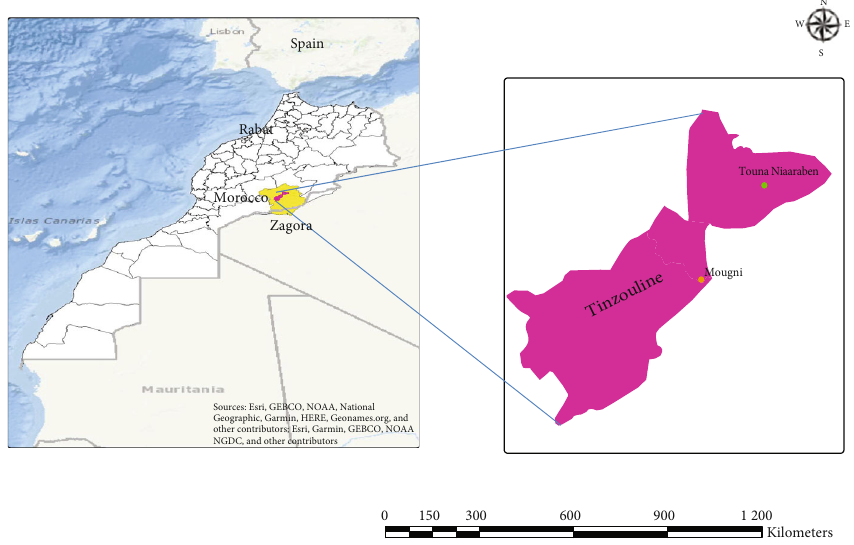
Figure 1: Map showing the location of the study sites. Table 1: Population, abundance, and sex ratio of sand fl y species in the two stations studied. Touna